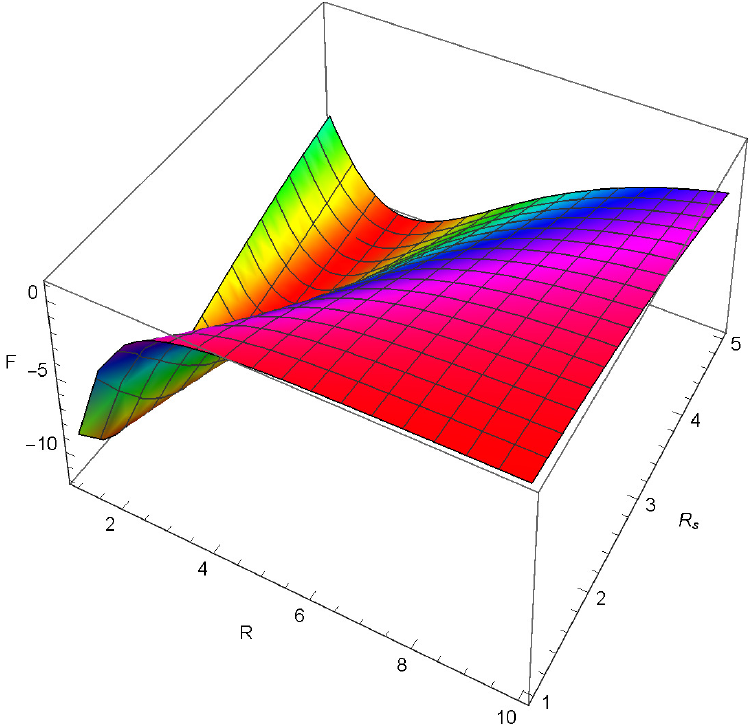
Figure 25. Solution of F ( R ( r )) for n = 1. The evolution of partial derivative of f ( R ) is obtained using Equations (33) and (44).